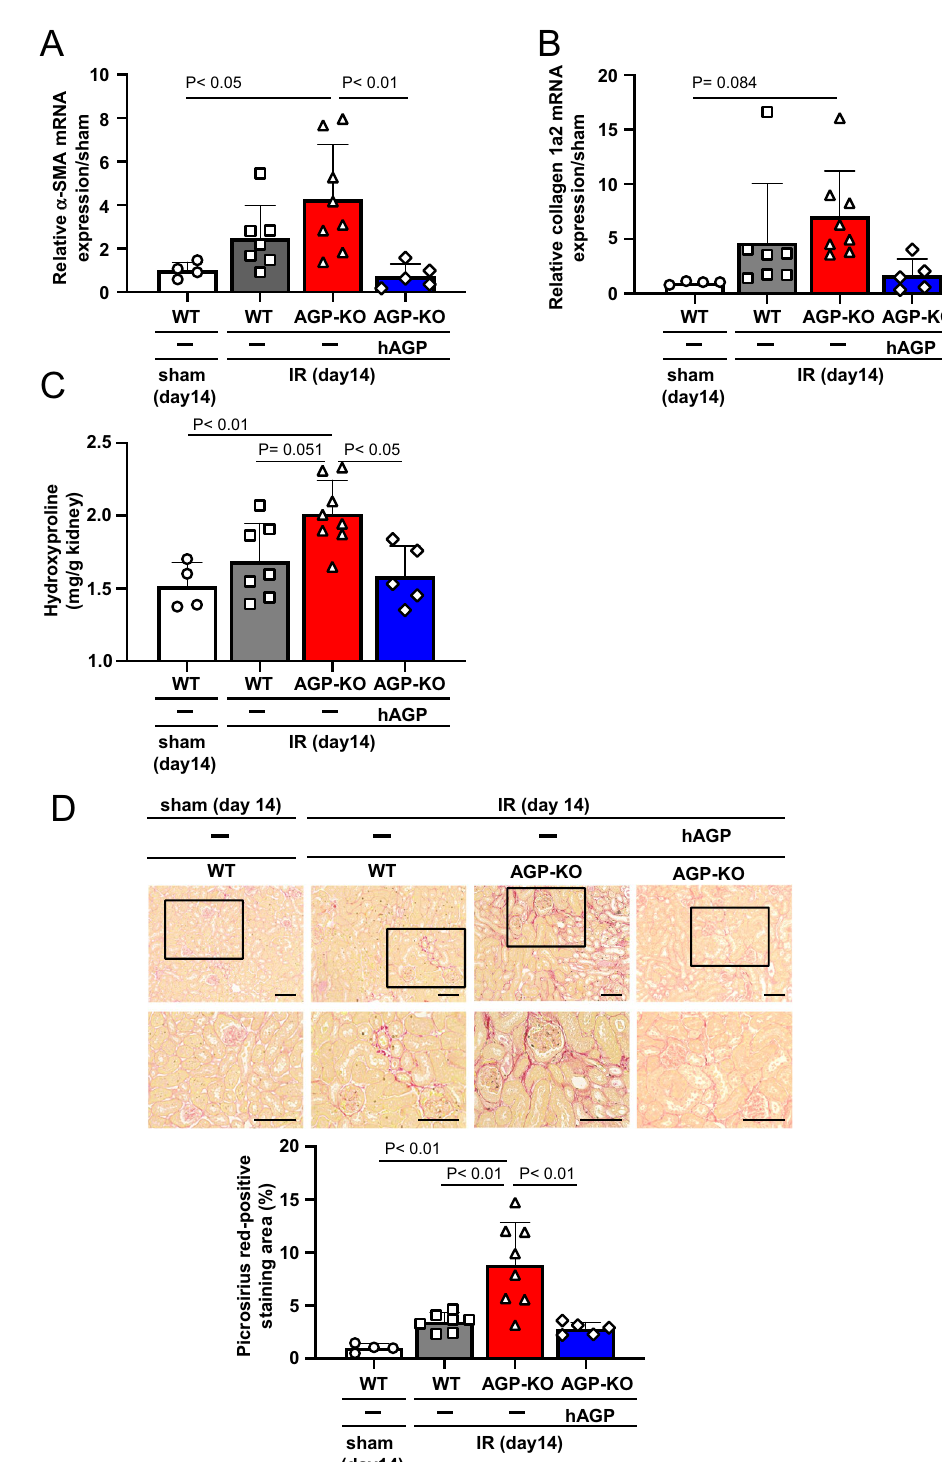
Figure 4. Administration of hAGP rescues renal fibrosis at day 14 after renal-IR in AGP KO mice. mRNA expression of ( A ) α-SMA and ( B ) Collagen 1a2 in kidney at day 14 after renal IR were determined by real-time PCR. ( C ) Hydroxyproline levels in the kidney were measured at 14 days after renal IR. ( D ) Representative photomicrographs of Picrosirius red-stained kidney sections and a semi-quantitative scoring analysis of picrosirius red-positive staining area at 14 after renal IR are shown. Lower panels are an enlarged image of the upper panel. Original magnification: × 200 (upper panels), × 400 (lower panels). Scale bars represent 100 μm. hAGP administration to AGP KO mice (2 mg/mouse/day, ip , from day 0 (before IR) to day 7) rescued IR-induced renal fibrosis. Date are expressed as the means ± SE (n =